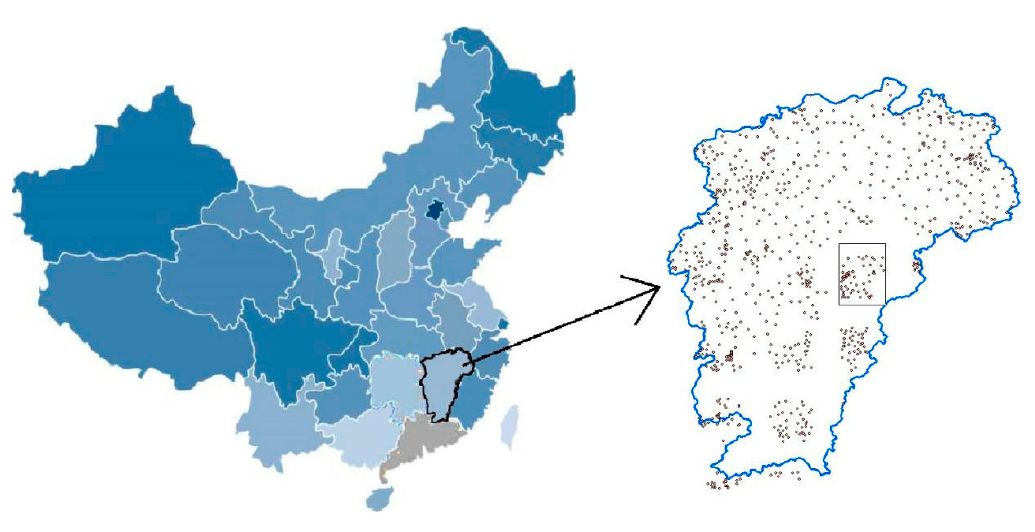
Figure 15. Schematic map of rainfall stations in Jiangxi.